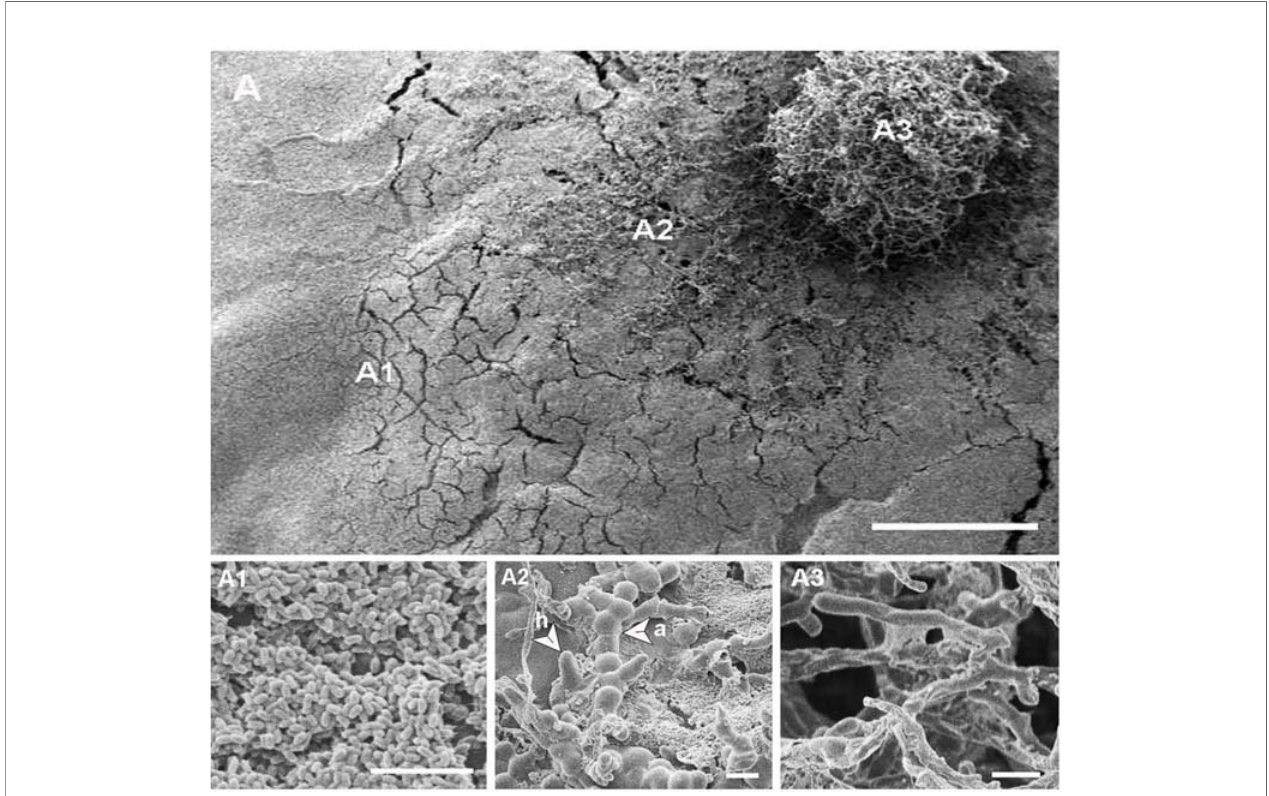
FIGURE 5 | (A) Scanning electron micrograph of a three-week-old heterogeneous Neopseudocercosporella capsellae isolate UWA Wlj-3 colony on PDA, showing cell types with different morphologies at different places in the culture, scale bar = 500µm. (A1) Blastospores (yeast cells) dominating at the periphery of the colony. (A2) Middle area of colony showing a mixture of blastospores, arthrospores (a) and hyphae (h). (A3) Centre of the colony dominated by true hyphae. Scale bars =